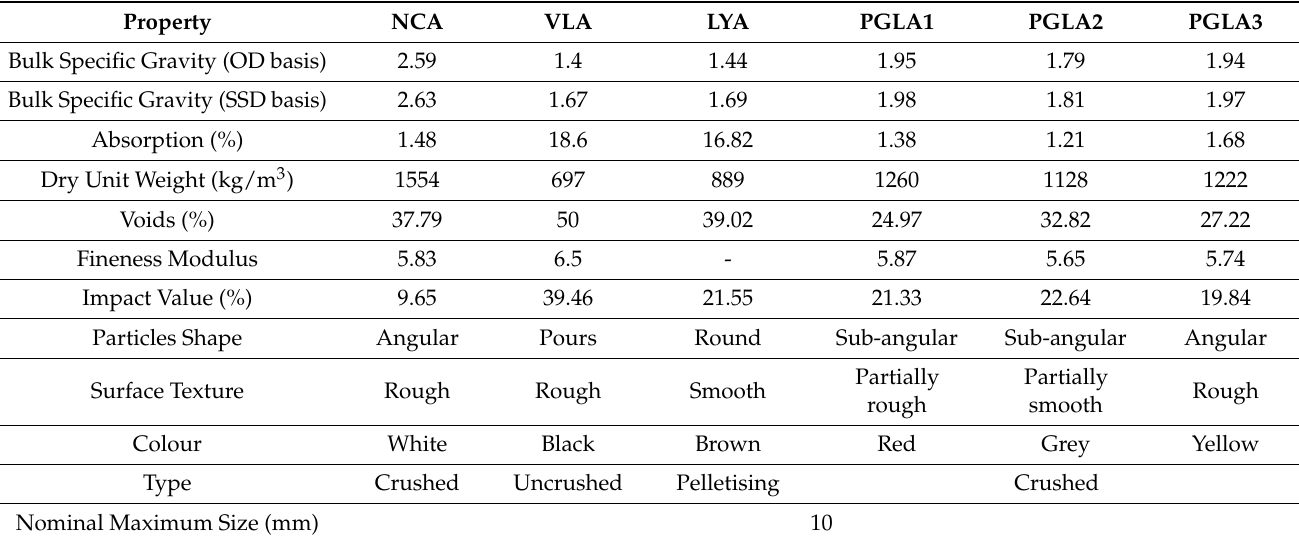
Table 5. Properties of the developed plastic based green lightweight aggregates (PGLAs) as compared to NCA, VLA and LYA.